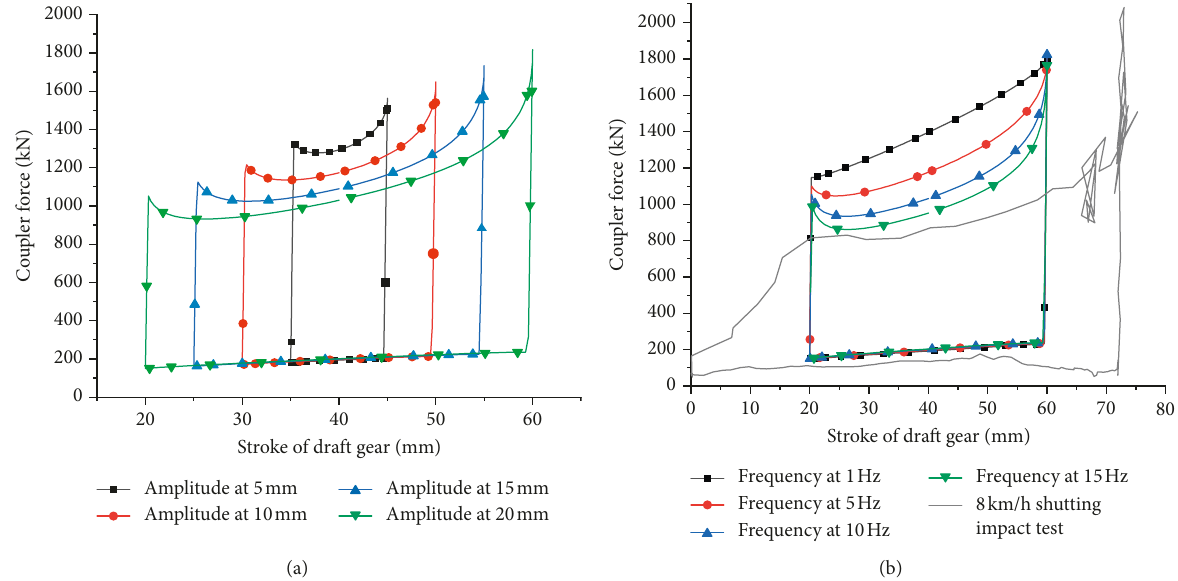
Figure 9: Bench test simulation with the wedge-spring model. (a) Bench test simulation at different amplitudes. (b) Bench test simulation at different frequencies.